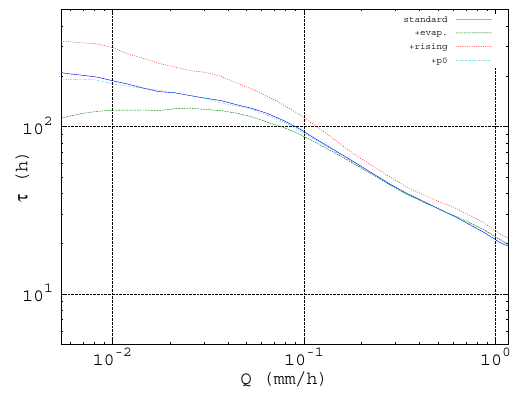
Fig. 6. Inverse-variance weighted mean recession timescale τ across sites (as in Fig. 5b) along with the mean recession timescale for sensitivity analyses where the hours considered (1) included periods of high evaporation, (2) included periods of rising flow, (3) used an absolute rather than a relative precipitation-intensity threshold for excluding hours with